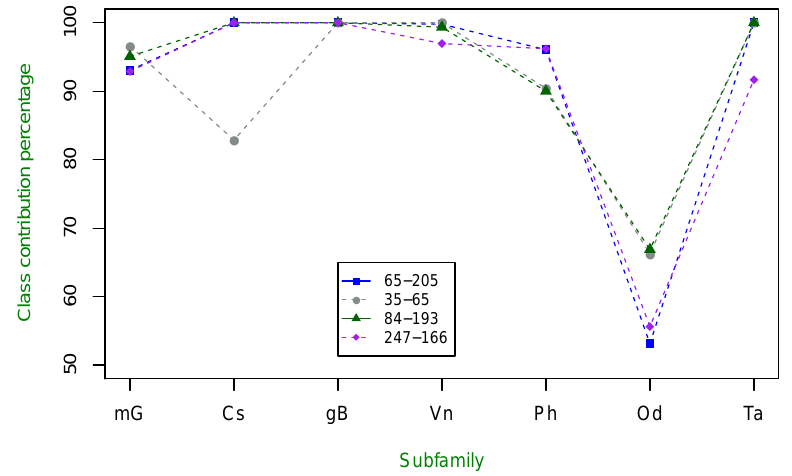
Figure 3. Class-specific percentage of contribution to overall classification using two amino acid property index combinations with the highest classification accuracy. The tendency of index combination results is similar to the results shown in Figure 2, but this time, the Ph and Od subfamilies are better discriminated.